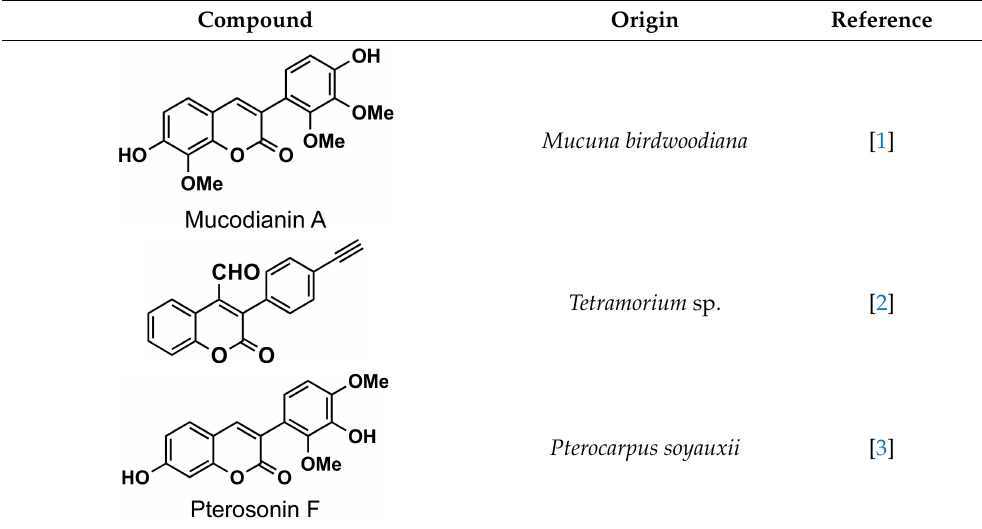
Table 1. Naturally-occurring 3-phenylcoumarins identified in the past